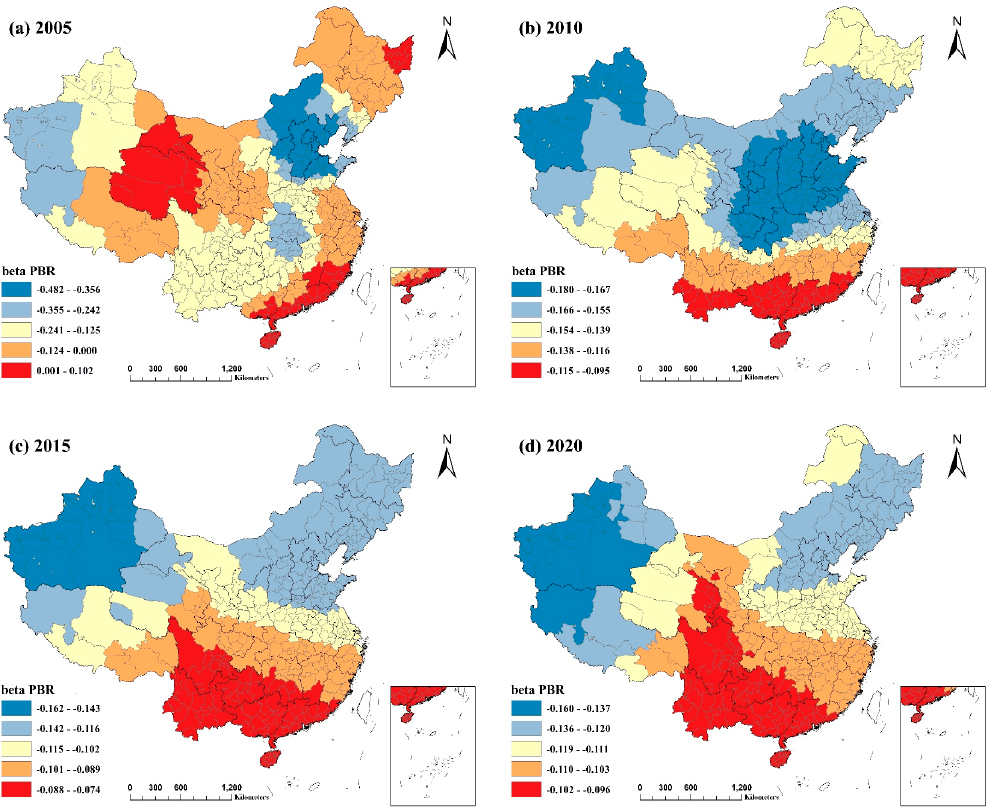
Figure 9. Spatial and temporal distribution of regression coefficients of the general public budget revenue as a proportion of GDP in the MGWR model, 2005 − 2020: ( a ) spatial and temporal distribution of regression coefficients for the general public budget revenue as a proportion of GDP in 2005; ( b ) spatial and temporal distribution of regression coefficients for the general public budget revenue as a proportion of GDP in 2010; ( c ) spatial and temporal distribution of regression coefficients for the general public budget revenue as a proportion of GDP in 2015; ( d ) spatial and temporal distribution of regression coefficients for the general public budget revenue as a proportion of GDP in 2020.